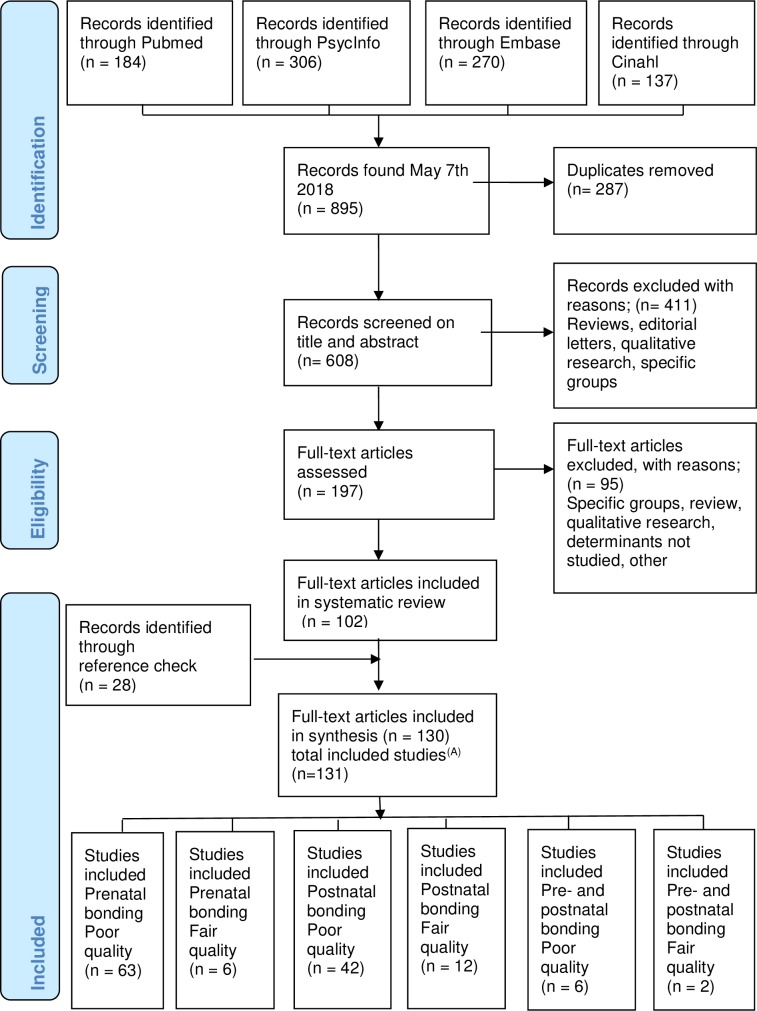
Flowchart of the systematic review.One included article described two different included studies.